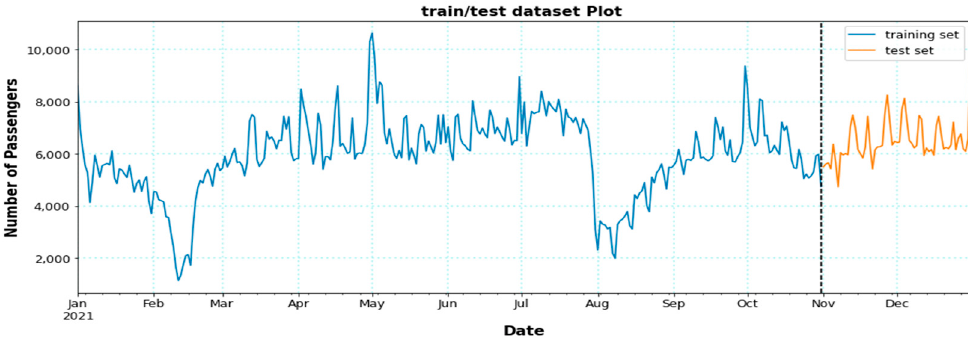
Figure 3. Daily training and testing datasets.